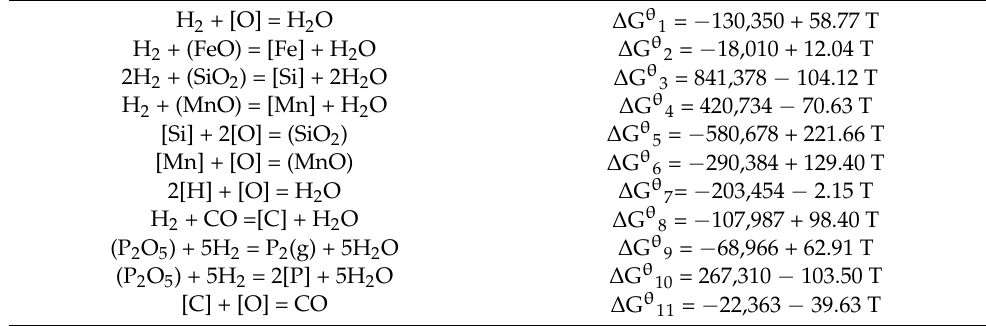
Table 3. Standard Gibbs free energies for some reactions related to hydrogen in the converter (J · mol − 1 ). H 2 + [O] = H 2 O ∆ G θ 1 = − 130,350 + 58.77 T